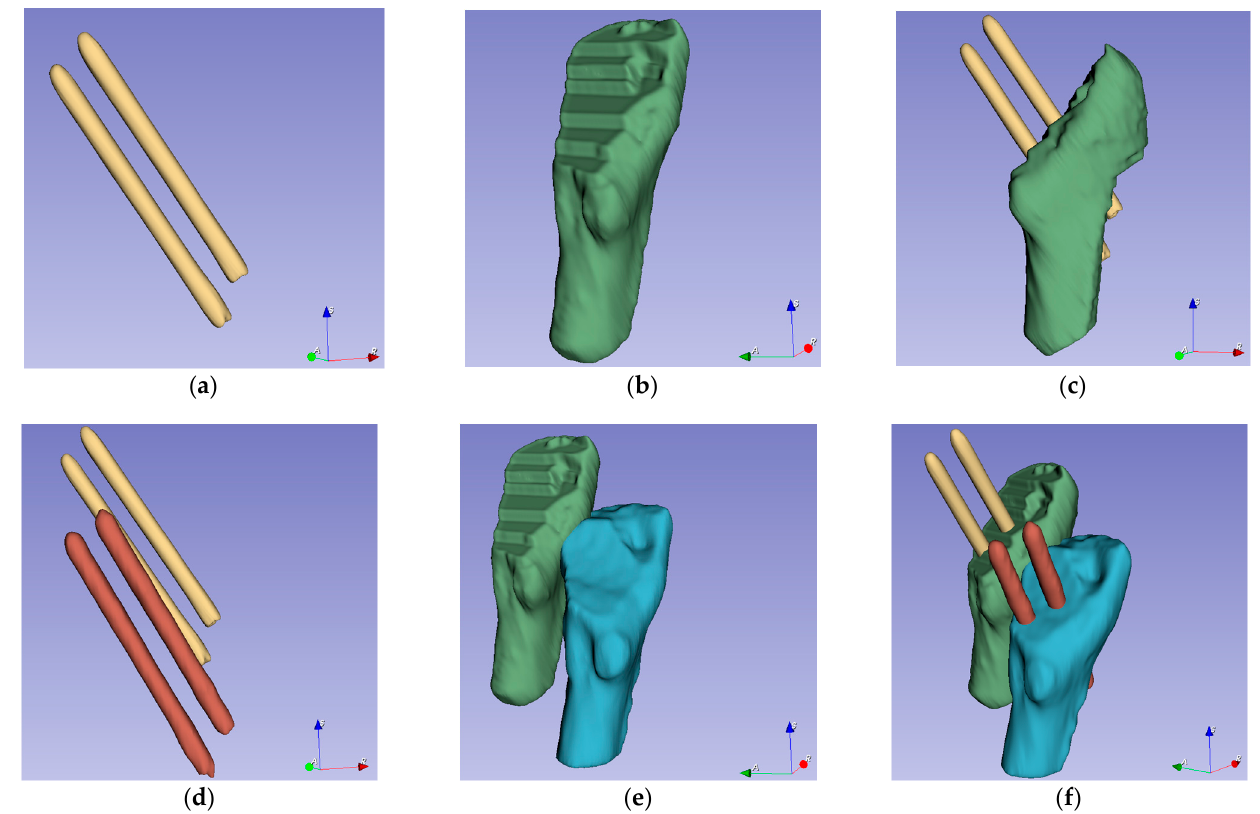
Figure 7. Using 3D Slicer to reconstruct 3D model of bone with the same initial direction: ( a ) The pins model reconstructed using CT images. ( b ) A part model of the femur. ( c ) Assembling the pins and femur from the same group of CT images in the same coordinate system. ( d ) Comparison of pins from different sets of dates. ( e ) The green model comes from postoperative data, and the blue model comes from CT images after a one-year recovery period. ( f ) All the models use the same initial direction.